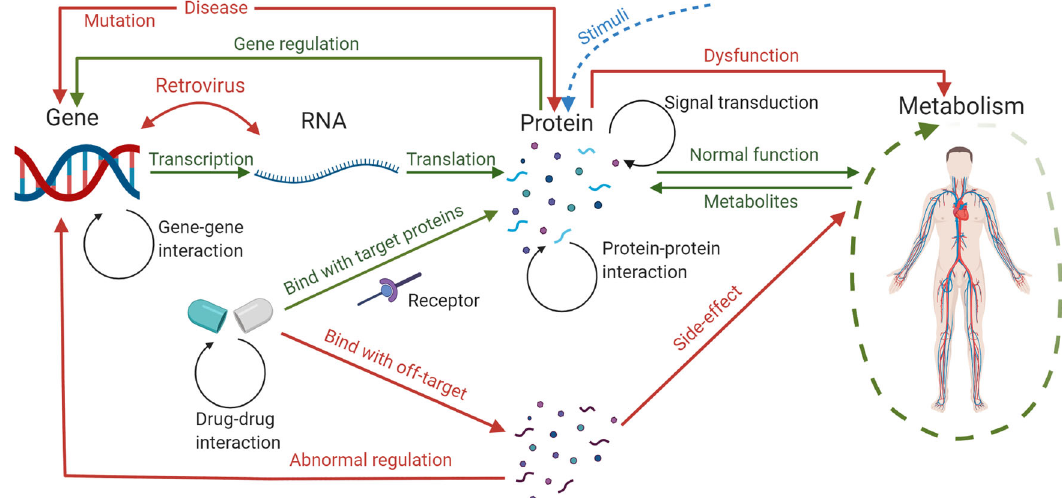
Fig. 1 A systemic view of disease. Interactions among genomic, proteomic and transcriptomic levels reveal the regulatory process within organisms. Drug molecules intervene in this process by binding with speci fi c target ligands. These omics data and chemical molecules are required to be analyzed simultaneously to study the entire disease mechanisms and drug reaction.